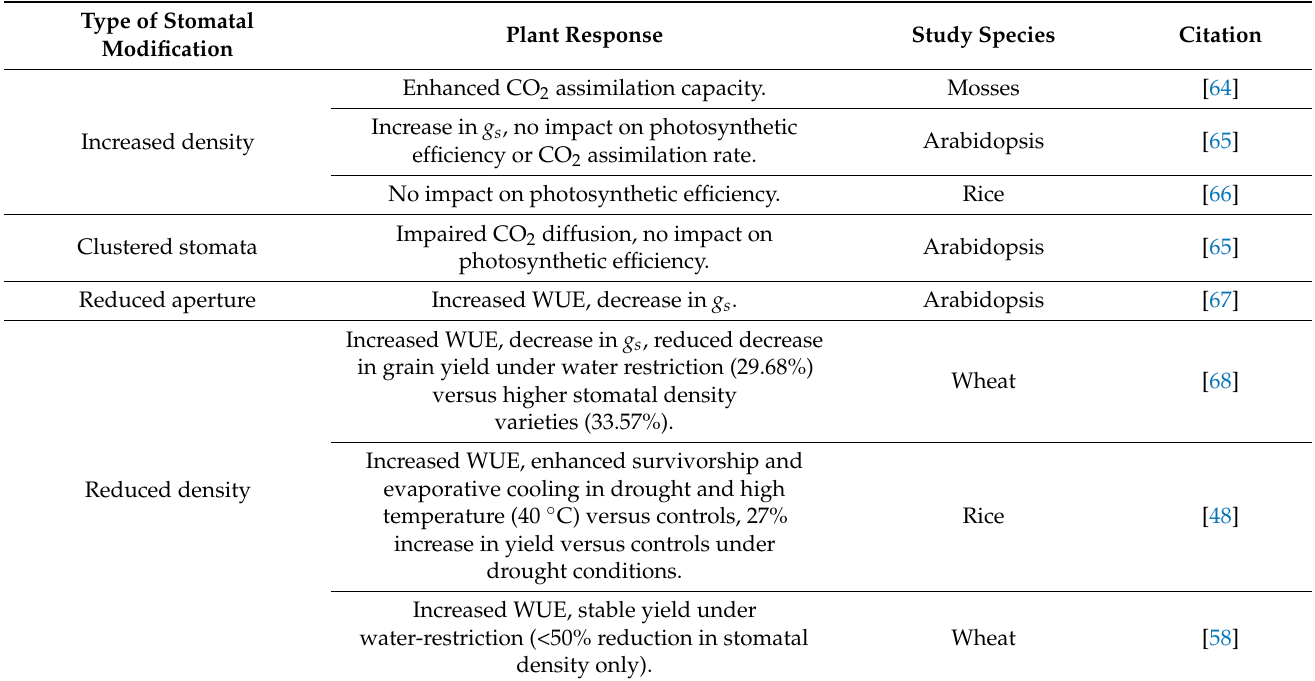
Table 1. Summary of studies investigating the impact of stomatal modification on plant WUE, stomatal conductance ( g s ), carbon assimilation, photosynthetic efficiency and grain